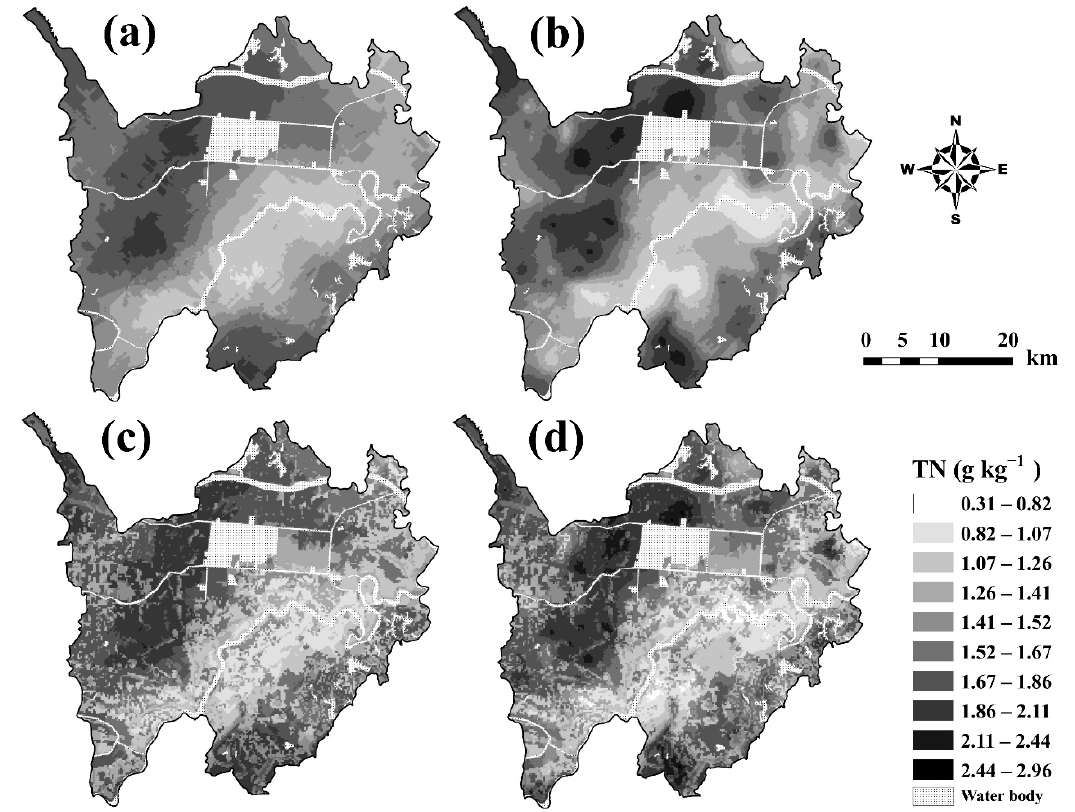
Figure 3. Spatial distribution patterns of soil TN predicted by ( a ) OK with 201 soil TN data; ( b ) RCoK with 201 soil TN data and 402 SOM data; ( c ) RRK with 201 soil TN data and LUTs; and ( d ) RRCoK with 201 soil TN data, 402 SOM data, and LUTs.